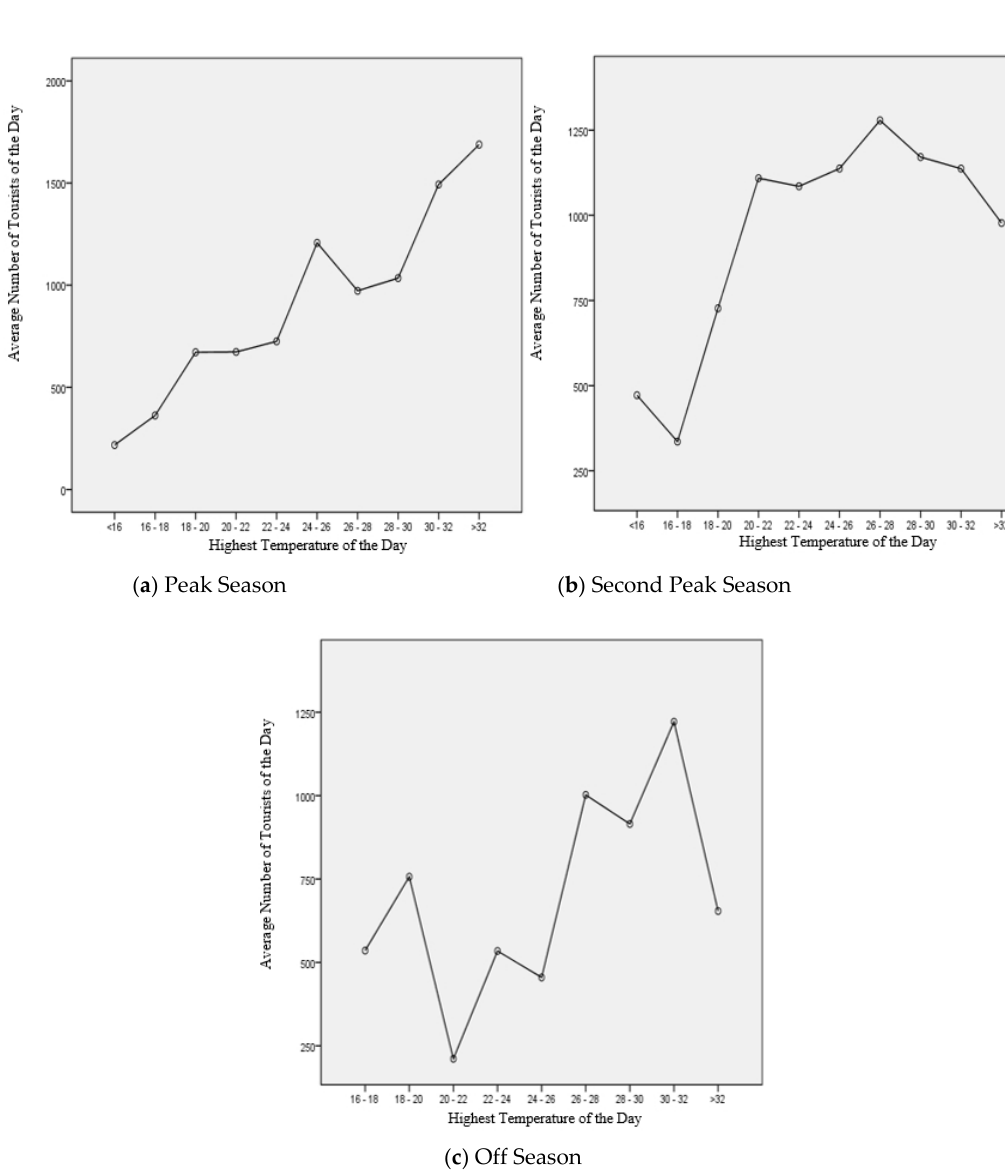
Figure 7. The relationship between the number of tourists in the peak season, second peak season, off season, and the grouped maximum temperature of the day.